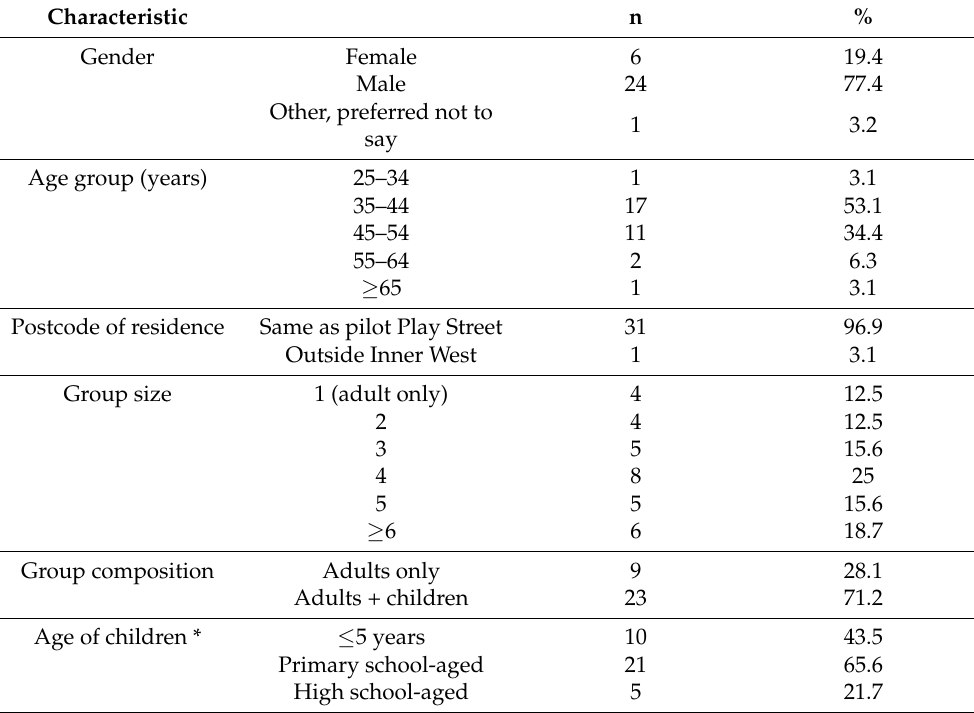
Table 1. Pilot Play Street intercept survey respondent characteristics (n =